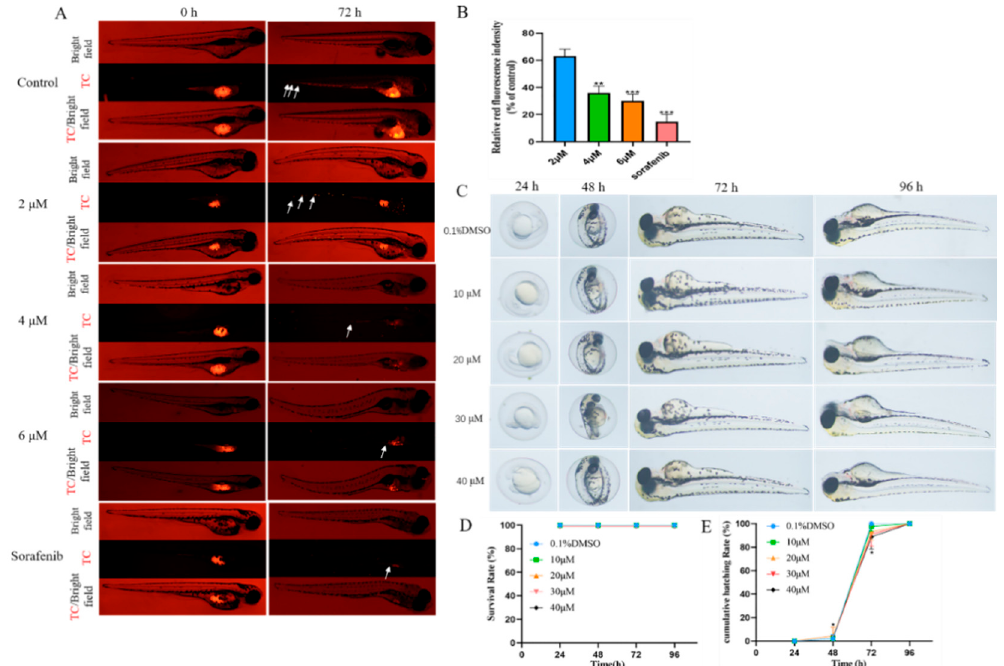
Figure 8. Inhibitory effect of ZS17 on the proliferation of HepG2 cells in a zebrafish xenograft model and toxicity assessment of ZS17 . ( A ) Proliferation of HepG2 cells in zebrafish after treatment with ZS17 (0, 2, 4, and 6 μ M). White arrows: tumor cells. ( B ) Quantified relative red fluorescence in zebrafish embryos using ImageJ software. ( C ) Ecotoxicology study of different concentrations. ( D , E ) Survival rate and cumulative hatching rate of zebrafish embryos treated with ZS17 . Microscope’s magnification is 40×. Data are expressed as mean ± SD. Compared with model group: ** p < 0.01, *** p < 0.001. n = 3 per group.